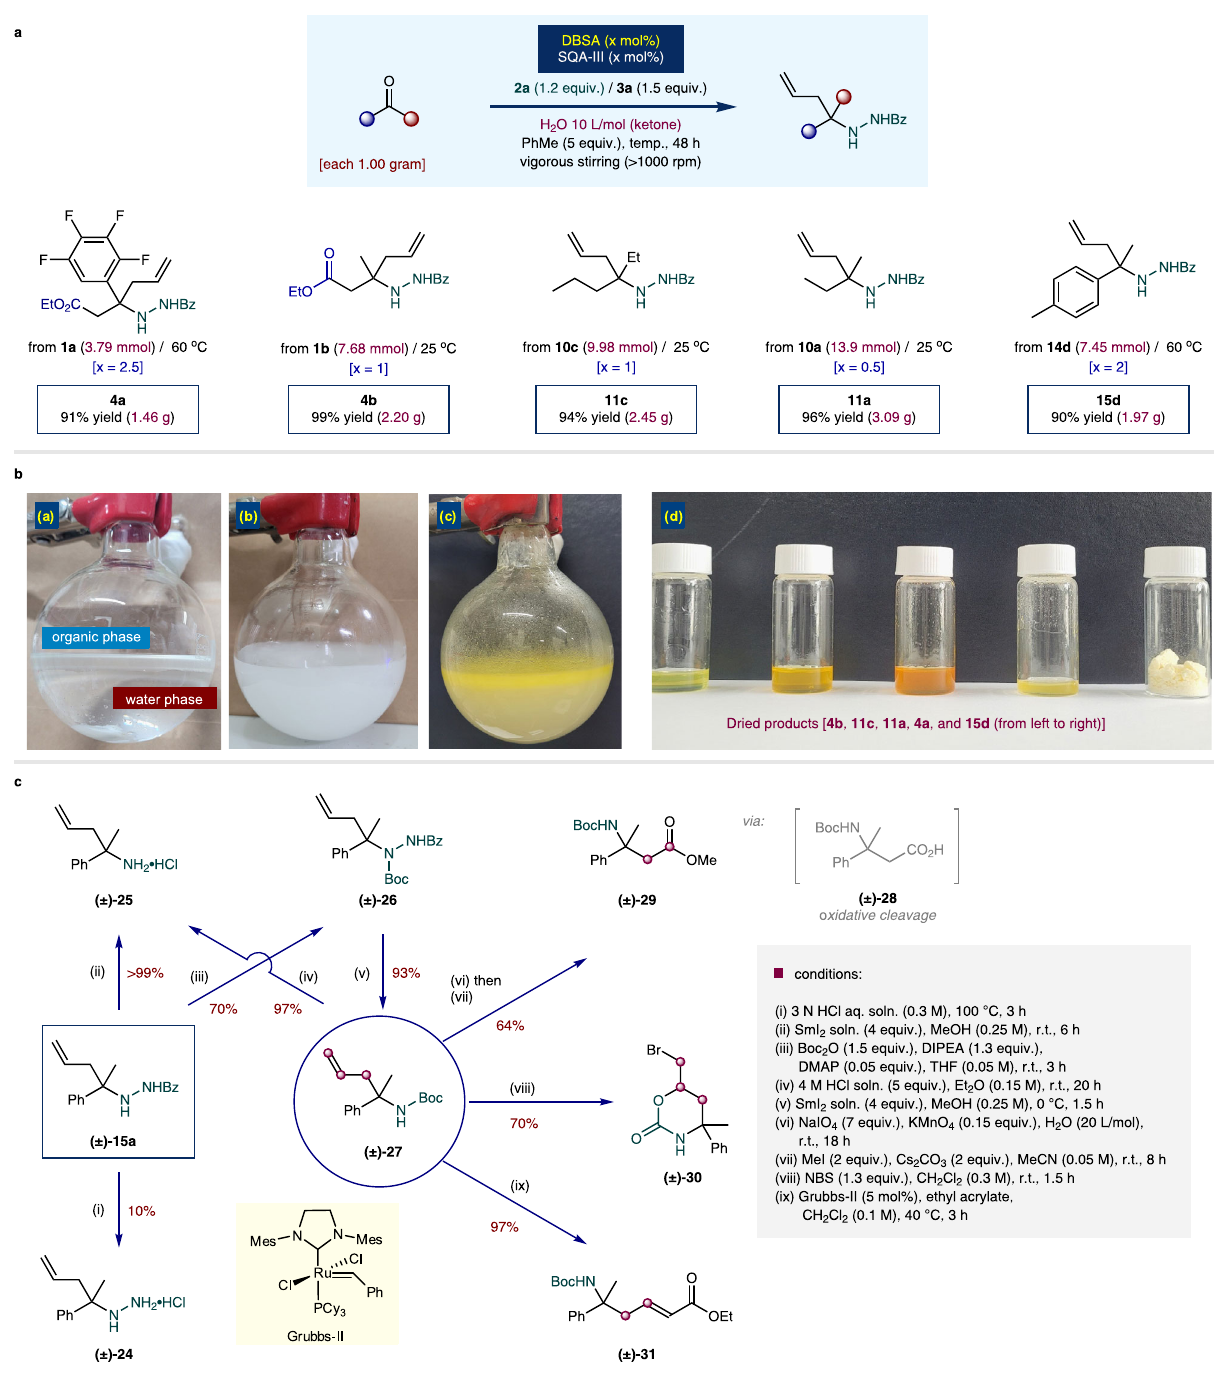
Fig. 6 Synthetic applications of catalytic allylation. a Gram-scale synthesis. b Pictures of biphasic mixtures and puri fi ed products. c Synthetic utilities